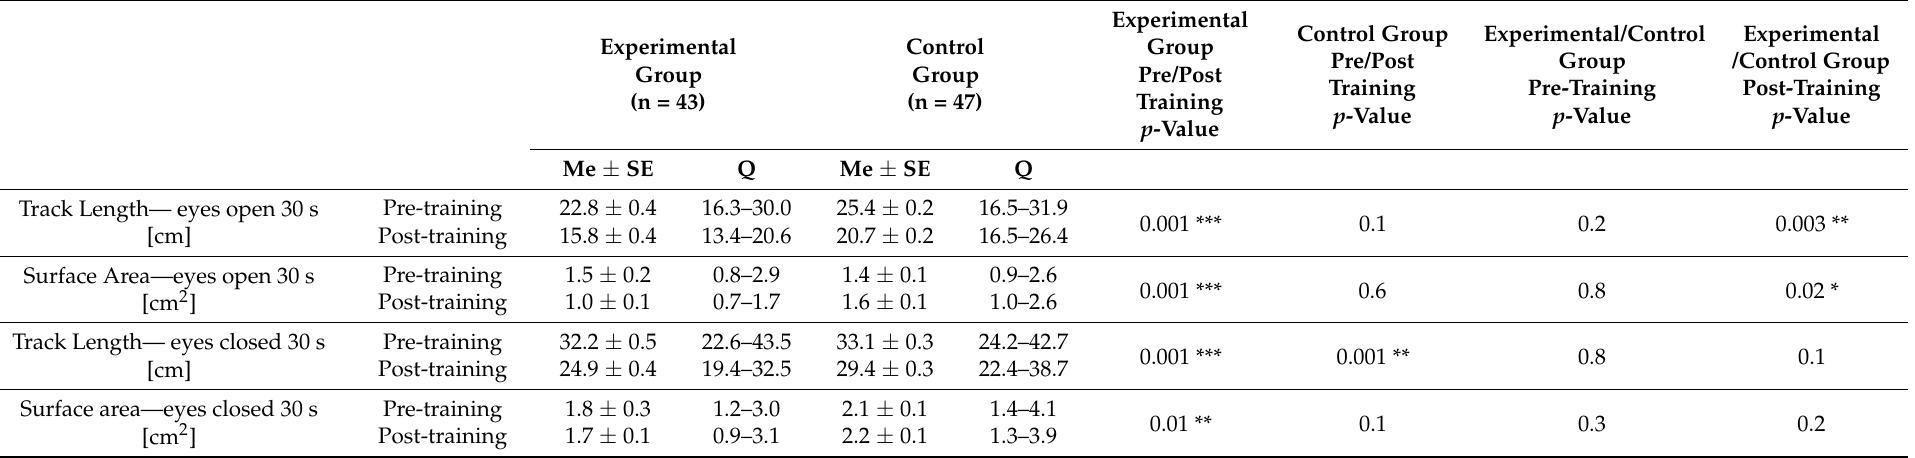
Table 2. Effects of a 10-week program of sensorimotor exercises on the results of the static test—stabilometric platform.